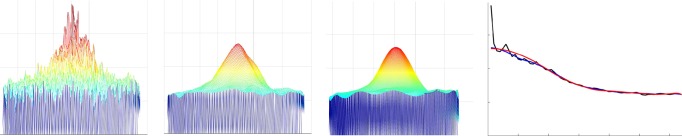
Fitting ZP to 2W-AF MP density maps.Left to right: 3D representation of a 2W-AF image; 3D representation of the image data after Gaussian smoothing (σ = 4); 3D representation of the ZP fit to the original 2W-AF image; and 2D profiles of the unprocessed 2W-AF data (black), Gaussian smoothed 2W-AF data (blue) and ZP fit (red).